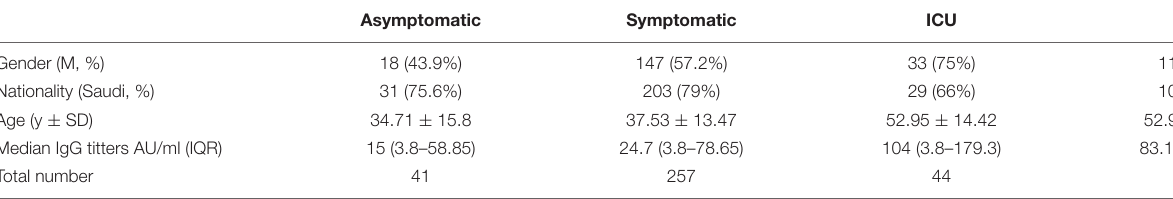
TABLE 1 | Baseline demographics and IgG titers stratified by disease severity. Asymptomatic Symptomatic